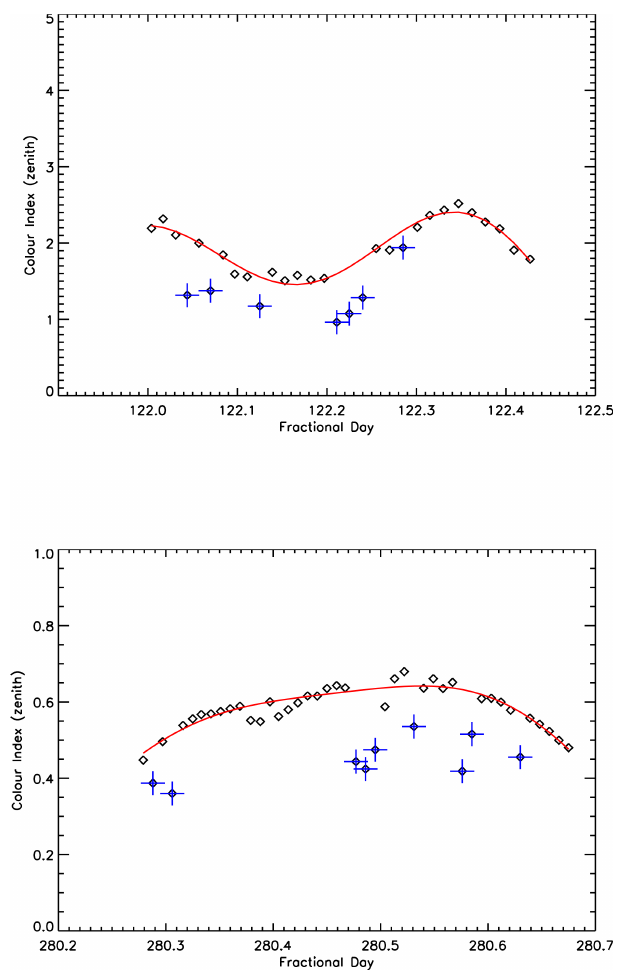
Figure 8. Results of the CI modelling (red line) to the measured CI values (black diamonds) and outlier detection (blue crosses) for the broken-cloud flagging, for example days in Xianghe and